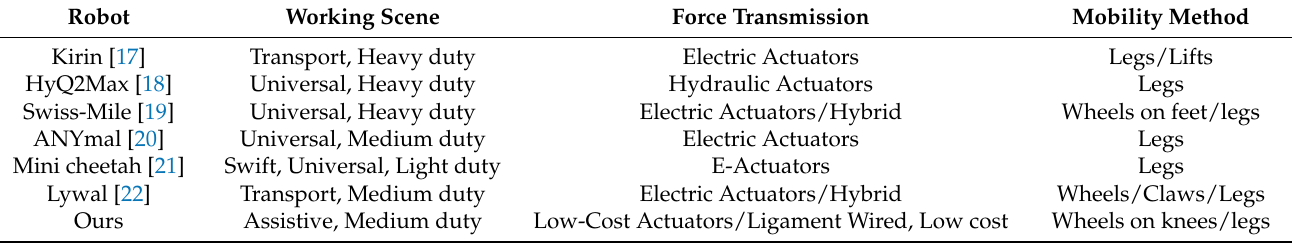
Table 1. Work scenes, force transmissions, and mobility features of relevant quadruped robots.